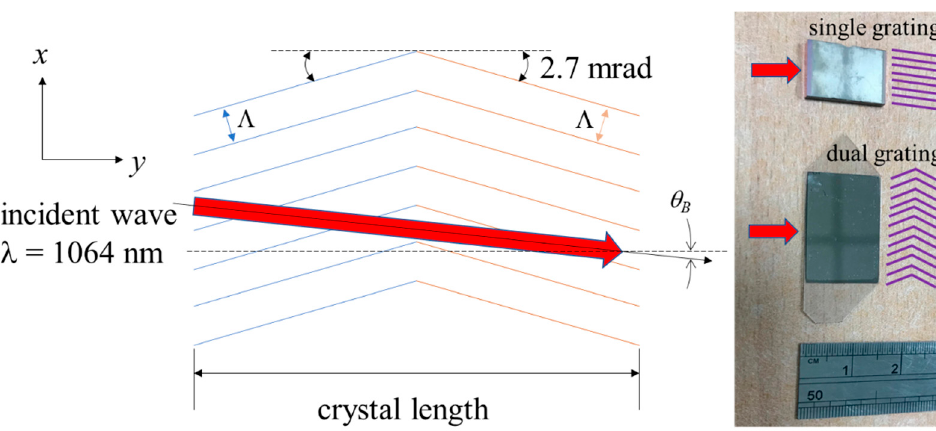
Figure 1. Schematic design of the dual-grating structure. The incident wave containing multiple spatial components has a wavelength of 1064 nm and propagates toward the y -direction. The two PPLN grating vectors form ±2.7-mrad angles with respect to the y -axis. The PPLN grating period Λ is 20.25 µ m. The Bragg angle θ B is 0.69° (12 mrad). Notice that the angle of the grating vector is exaggeratedly shown in this figure. The right picture shows the single-grating and the dual-grating samples used in the experiment.